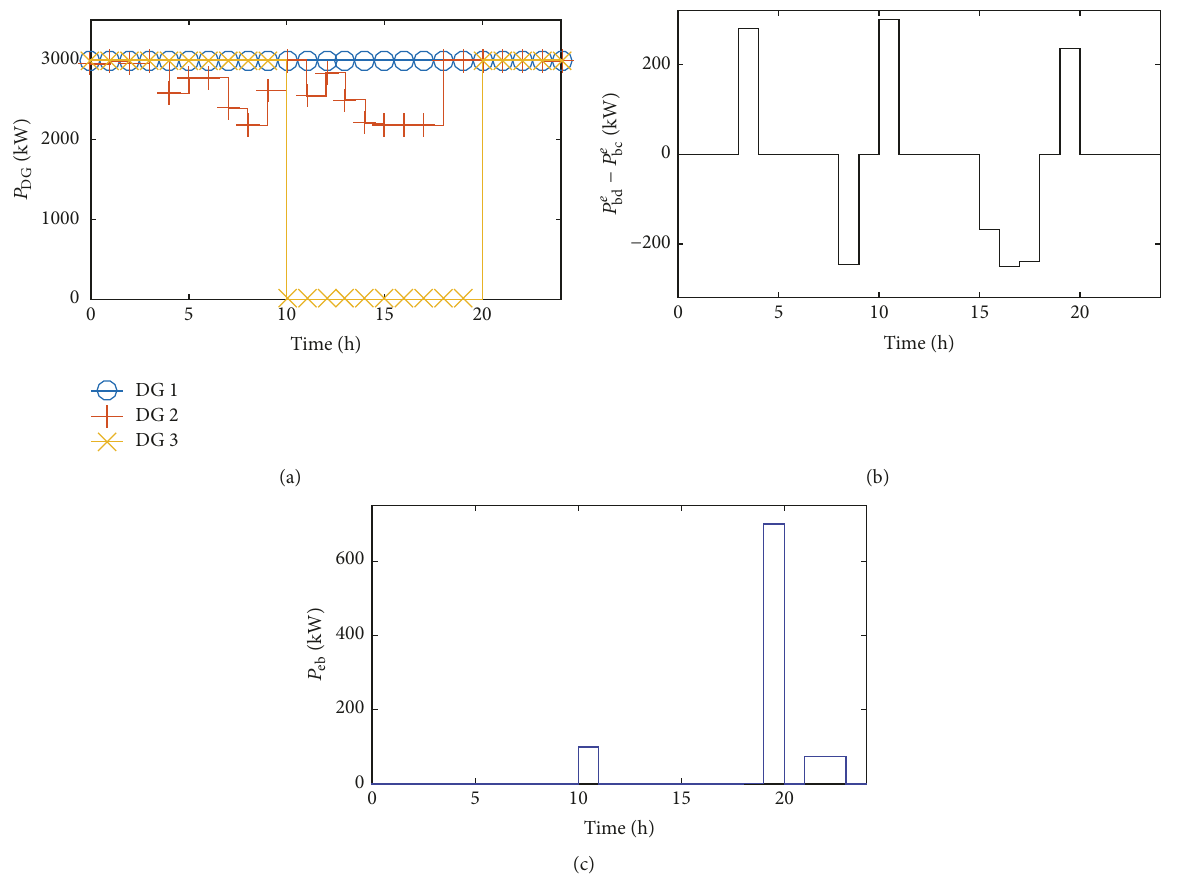
Figure 4: Scenario 2: (a) dispatch values of DG 1, DG 2, and DG 3, (b) BESS charge and discharge profiles, and (c) 𝑃 eb .